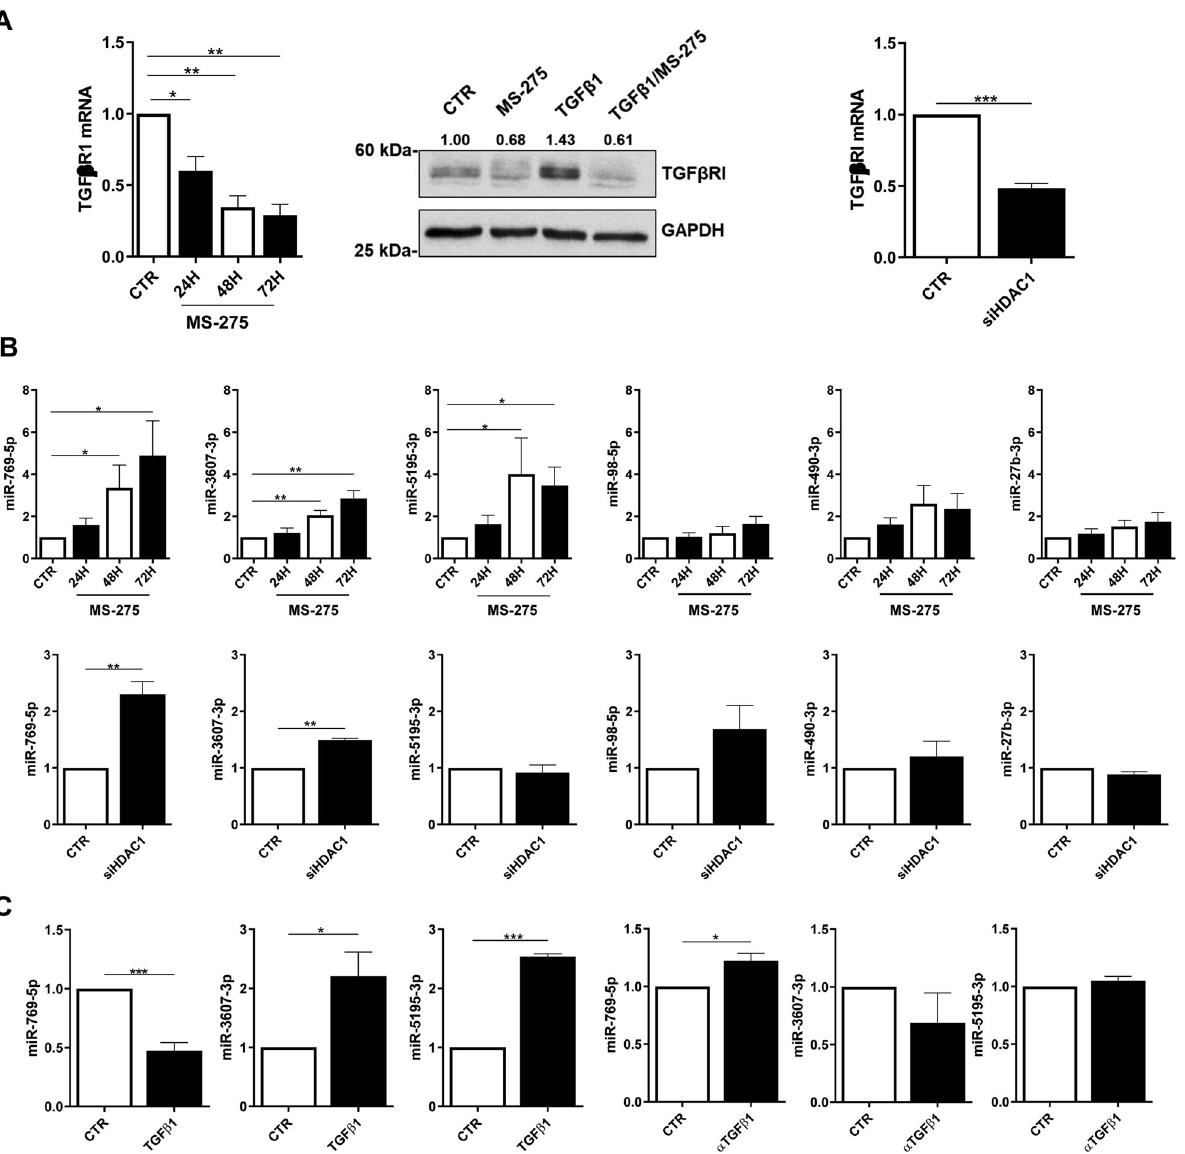
Fig. 1 HDAC1 inhibition promotes the expression of anti fi brotic miRNAs targeting TGFBRI mRNA. A left , RT-PCR showing the expression of TGFBRI mRNA in MCs from PD patients treated with MS-275 (250 nM for, 24, 48 and 72 h). Quantitative RT-PCR was performed on total RNA. L34 mRNA levels were used for normalization. Bars represent the mean ± SEM of triplicate determinations in four independent experiments. middle , WB showing the expression of TGFBRI from the same experiment. GAPDH was used as a loading control. Data are representative of three independent experiments. right , RT-PCR showing TGFBRI mRNA expression upon HDAC1 genetic silencing using a speci fi c siRNA. L34 mRNA levels were used for normalization. Bars represent the mean ± SEM of duplicate determinations in four independent experiments. B top , RT-PCR showing the expression of miR-769-5p, miR3607-3p, miR5195-3p, miR-98-5p, miR-490-3p and miR-27b-3p upon exposure to MS- 275 at the same conditions as in A miR-16 was used for normalization. Bars represent the mean ± SEM of duplicate determinations in fi ve independent experiments. Bottom , the expression of the same miRNAs was analyzed upon HDAC1 genetic silencing. miR-16 was used for normalization. Bars represent the mean ± SEM of duplicate determinations in four independent experiments. C RT-PCR showing the expression of miR-769-5p, miR3607-3p and miR5195-3p upon treatment with TGF β 1 (2 ng/ml for 72 h) ( top ), or upon treatment with anti-TGF- β 1 monoclonal antibody 1D11.16 (100 μ g/ml). ( bottom ). Bars represent the mean ± SEM of duplicate determinations in three to fi ve independent miR-769-5p ectopic expression is suf fi cient to inhibit TGF β 1- of mesenchymal markers observed after miR-769-5p genetic silencing induced MC migration and invasion was also con fi rmed at protein level by WB (Fig. 2C) In line with these results, miR-769-5p ectopic expression, Since complementary miR-769-5p target sequences were found irrespectively of concomitant TGF β 1 stimulation, was found to in SMAD2, SMAD3, and PAI 3 ’ UTR mRNA, luciferase experiments promote the downregulation of mesenchymal markers as well as were performed to demonstrate direct interaction. Indeed, miR- OCCLUDIN epithelial marker upregulation (Fig. 3A). The down- 769-5p was demonstrated to bind directly to the 3 ’ UTR of SMAD2, regulation of mesenchymal markers after the miR-769-5p ectopic SMAD3, and PAI1 mRNA. A direct binding to TGFBRI mRNA was expression was also con fi rmed at protein level by WB (Fig. 3B). also con fi rmed (Fig. 2D).